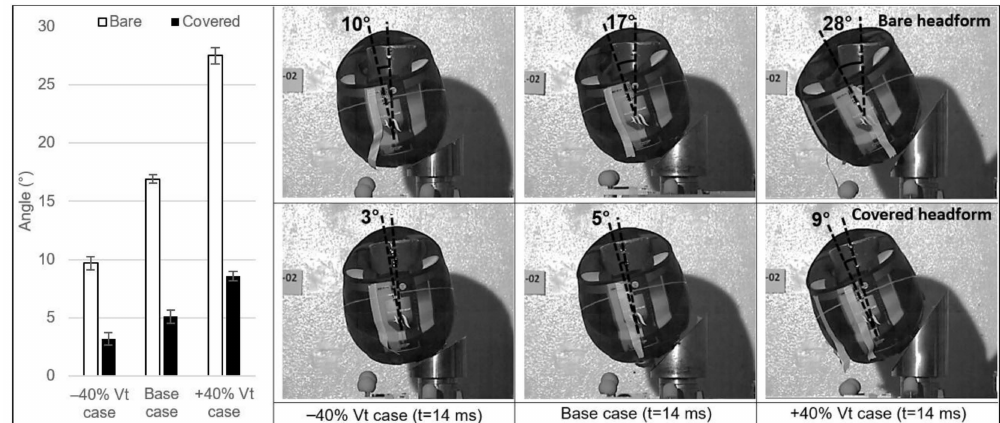
Figure 6. Comparison of the relative motion of the bare and covered headform inside the helmet at 14 ms of the left-side impact for each tangential velocity.